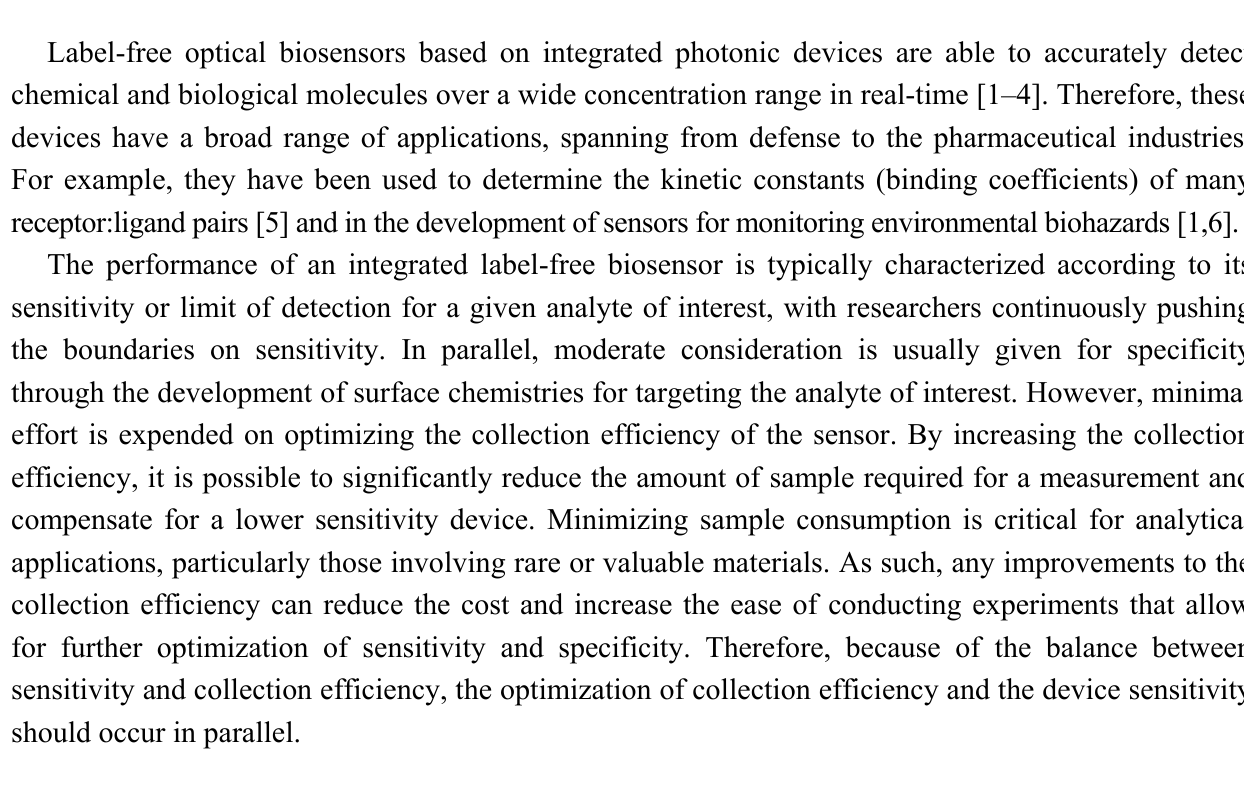
Figure 1. Suspended waveguide splitter/coupler biosensor. ( a ) Rendering of the biosensor integrated into a simple microfluidic flow cell. Light confined within the waveguide is shown in red, and the flow cell is shaded blue-green. The arrows indicate the direction of the fluid flow, which is perpendicular to the waveguide, interacting only with the suspended splitter/coupler region; ( b ) Rendering of the waveguide splitter/coupler device highlighting the energy transfer between the two coupling/splitting arms of the device; ( c ) Side view scanning electron micrograph (SEM) of the suspended region of the waveguide